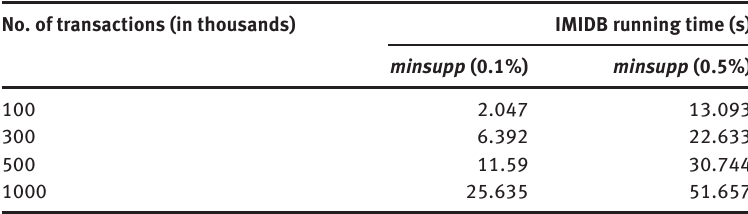
Table 13: Running Time of IMIDB with Respect to Database